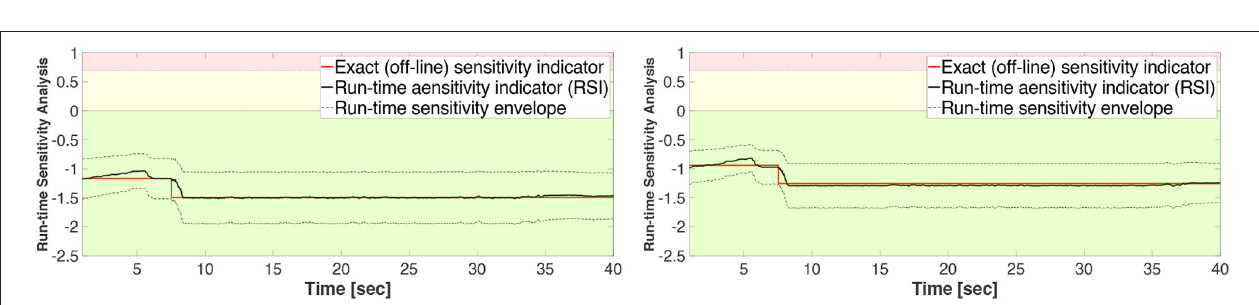
FIGURE 14 | Study 2 (Case 4): vRTHS response comparisons of the 1st and 3rd floor displacements under El Centro excitation.